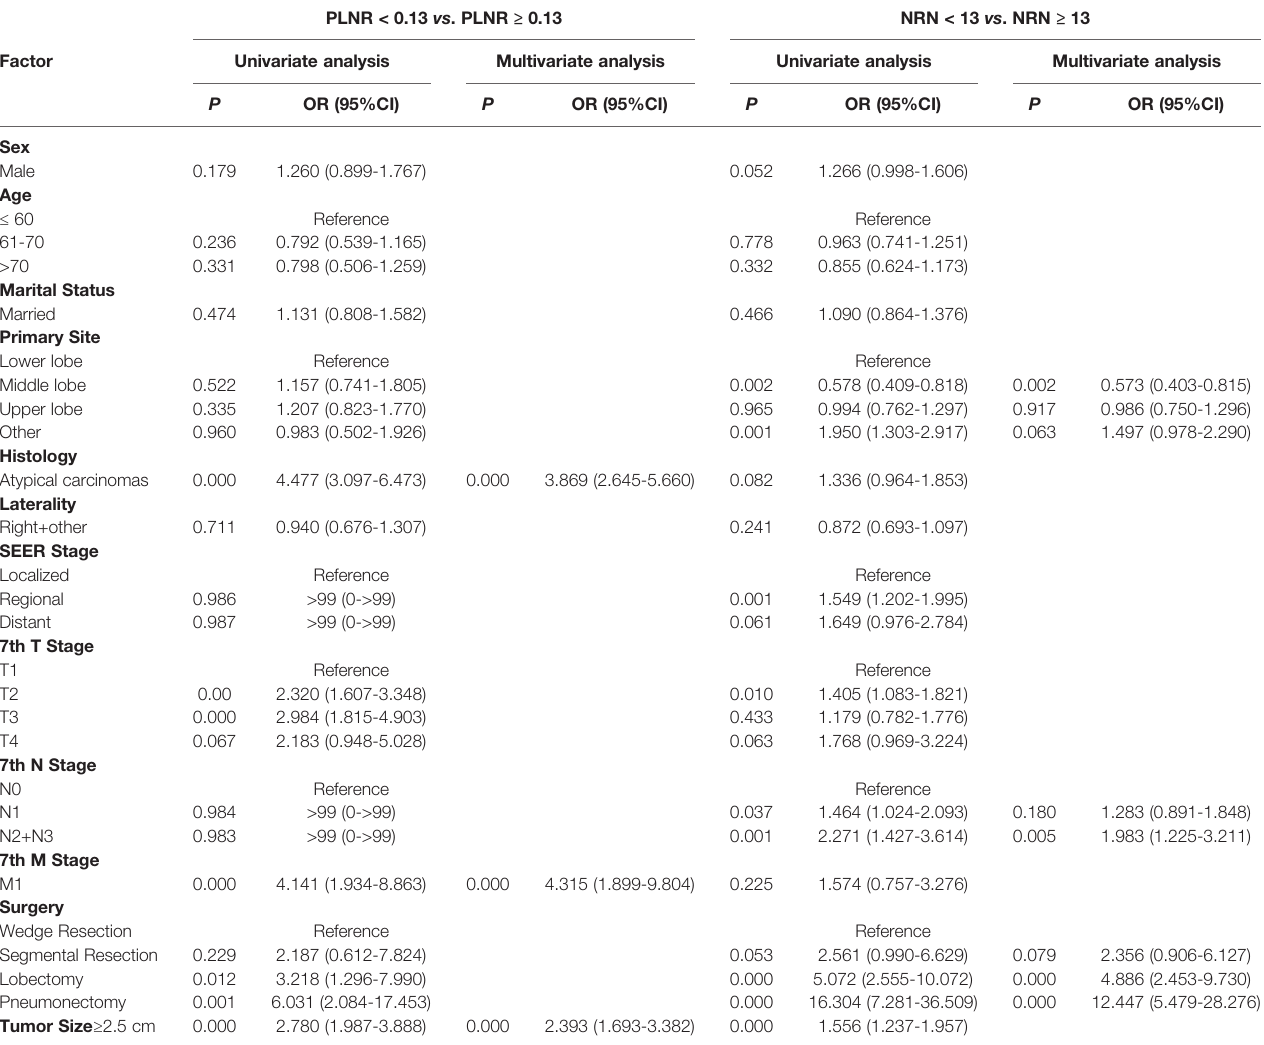
TABLE 3 | Multivariable logistic regression model predicting PLNR level and NRN level in unweighted study population. PLNR < 0.13 vs . PLNR ≥